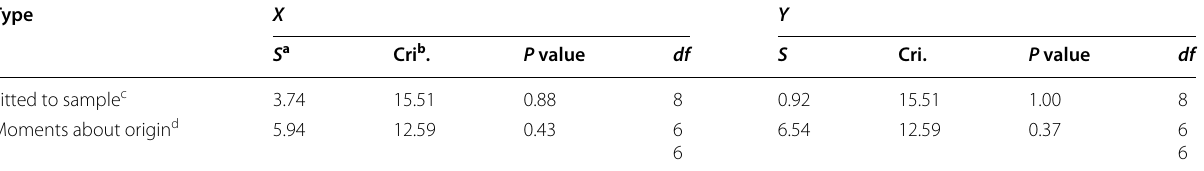
a Test statistics computed for the Chi square test